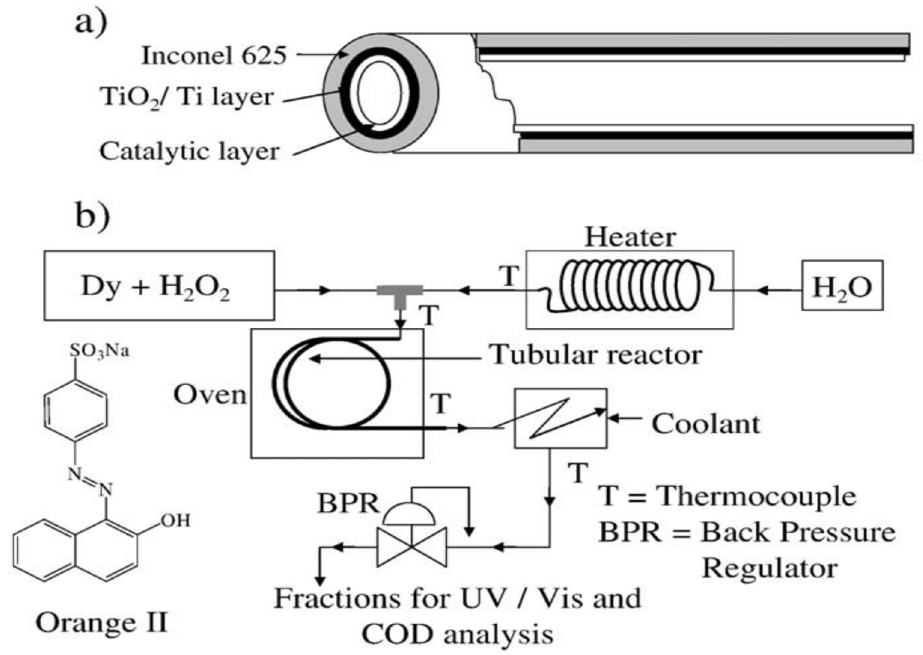
Figure 2. ( a ) Configuration of the catalyst-coated tubular reactor; ( b ) diagram of the HPHT-H 2 O flow reactor system [179].